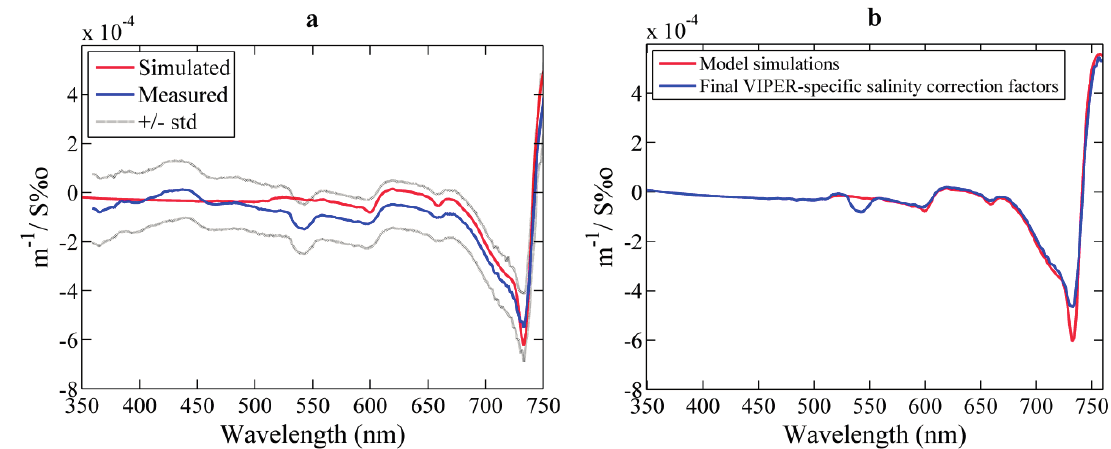
Figure 8. ( a ) Results from the salinity dependence analysis and comparison with model simulations based on the Max and Chapados [35] approach (red line). The blue line corresponds to the average over 20 experimental runs and its standard deviation is represented by dotted lines; ( b ) Final VIPER-specific ψ i S spectrum for pure water beam attenuation as a function of the wavelength (blue line) and comparison with model simulations (red